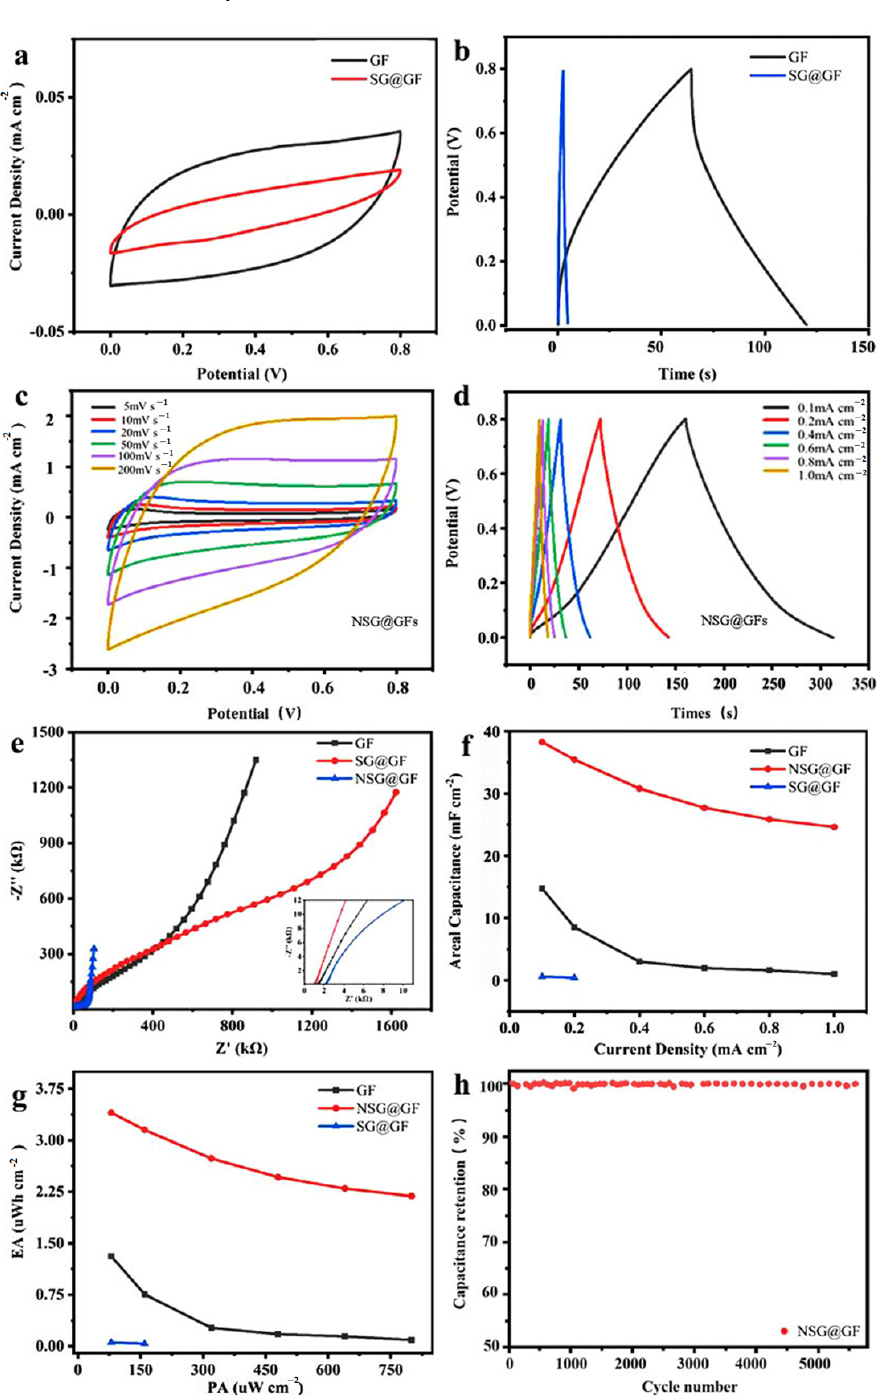
Figure 7. Electrochemical performances of GF, SG@GF, and NSG@GF. ( a ) CV curves of GF, SG@GF measured at a scan rate of 5 mV s − 1 . ( b ) GCD curves of GF, SG@GF measured at a current density of 0.1 mA cm − 2 . ( c ) CV curves of NSG@GFs measured at different scanning rate. ( d ) GCD curves of NSG@GFs measured at different current density. ( e ) Nyquist plots of GF, SG@GF, and NSG@GF. ( f ) Specific capacitances (CA) of GF, SG@GF, and NSG@GF based on GCD test and measured current density. ( g ) The Ragone plots of the FSSCs for GF, SG@GF, and NSG@GF graphene-based fiber electrodes. ( h ) Cycle life of